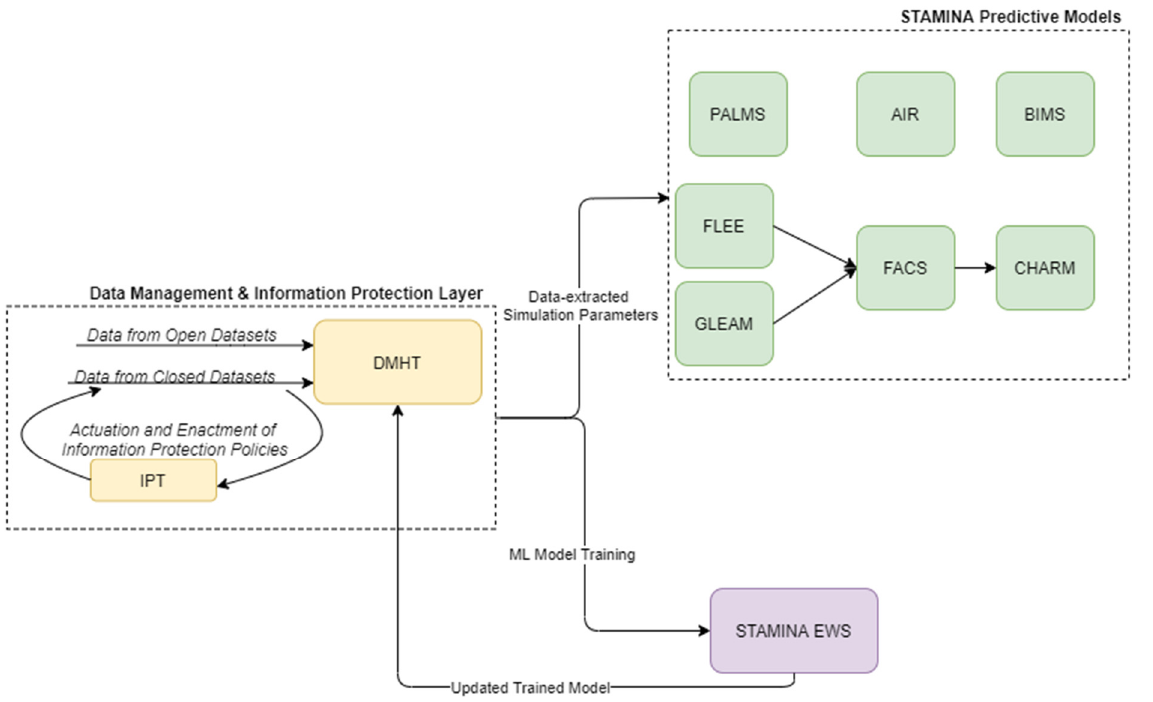
Figure 2. STAMINA System Design—Training and Deployment.